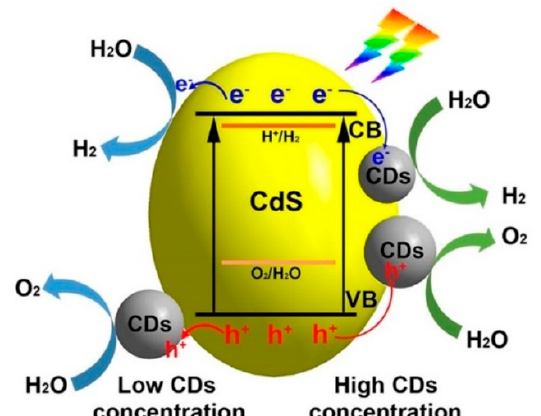
Figure 3. The proposed reaction mechanism of carbon dots-cadmium sulfide (CDs-CdS) under visible light irradiation. Figure adapted from reference [30].